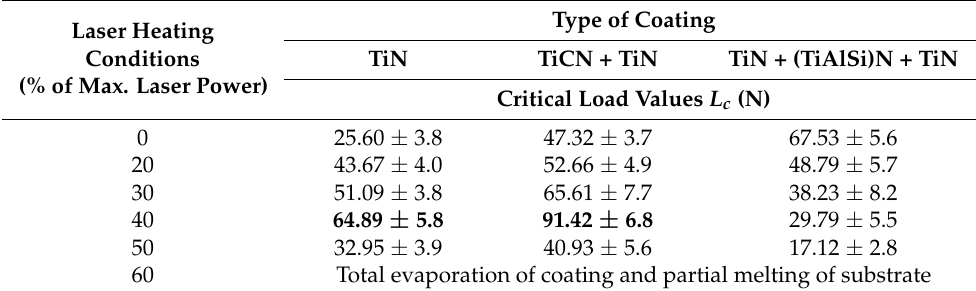
Table 5. Adhesion of the single-, double-, and triple-layer coatings to the sintered carbide substrates before and after laser heating conducted with different laser